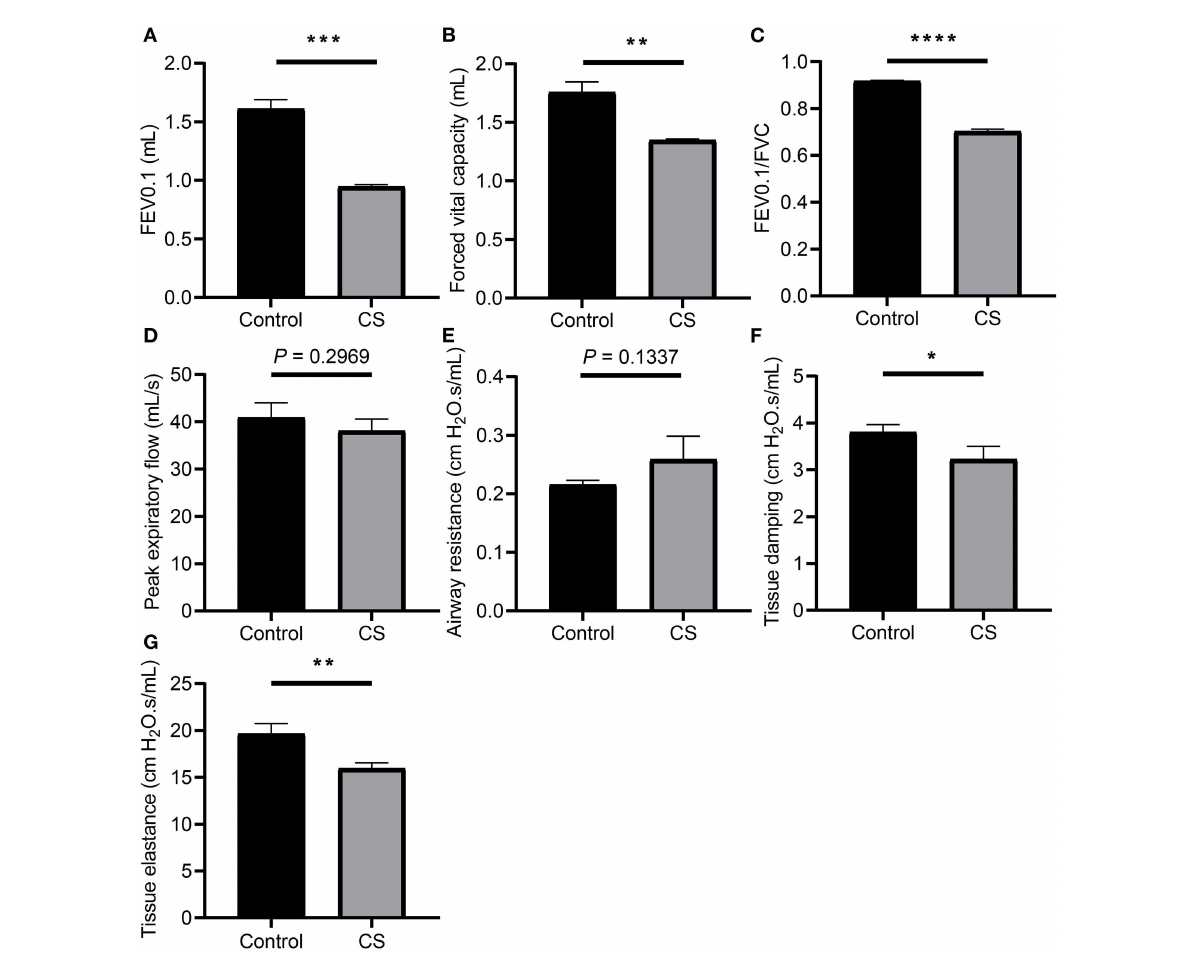
FIGURE1 Lung function measurement of mice from cigarette smoke treatment group and control group. (A) Forced expiratory volume in 100ms (FEV0.1). (B) Forced vital capacity (FVC). (C) Ratio of FEV 1 0.1 to FVC. (D) Peak expiratory flow (PEF). (E) Airway resistance (Rn). (F) Tissue damping (G) . (G) Tissue elastance (H) . * p < 0.05, ** p < 0.01, *** p < 0.001, and **** p <